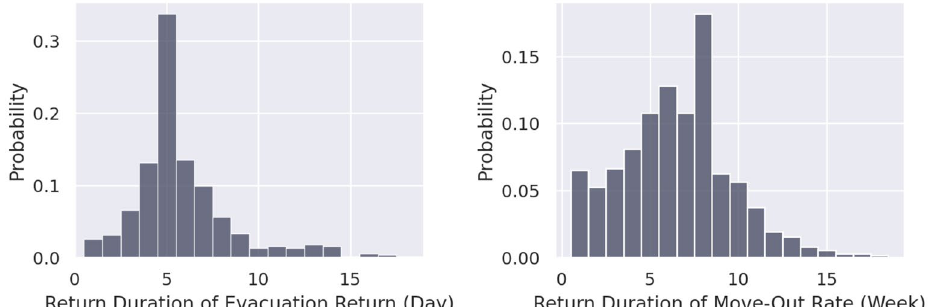
Figure 2. Distributions of the return duration of the evacuation rate (left) and home move-out rate (right) in Harris County, where the probability represents the number of census tracts over the total number of census tracts, which is 786, in Harris County.